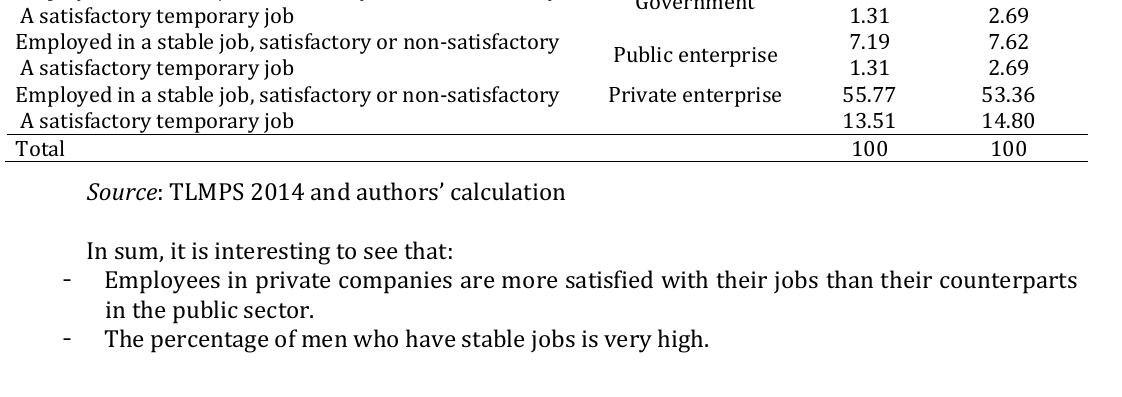
Table 5: Transited youth by category, gender and employment sector (%)